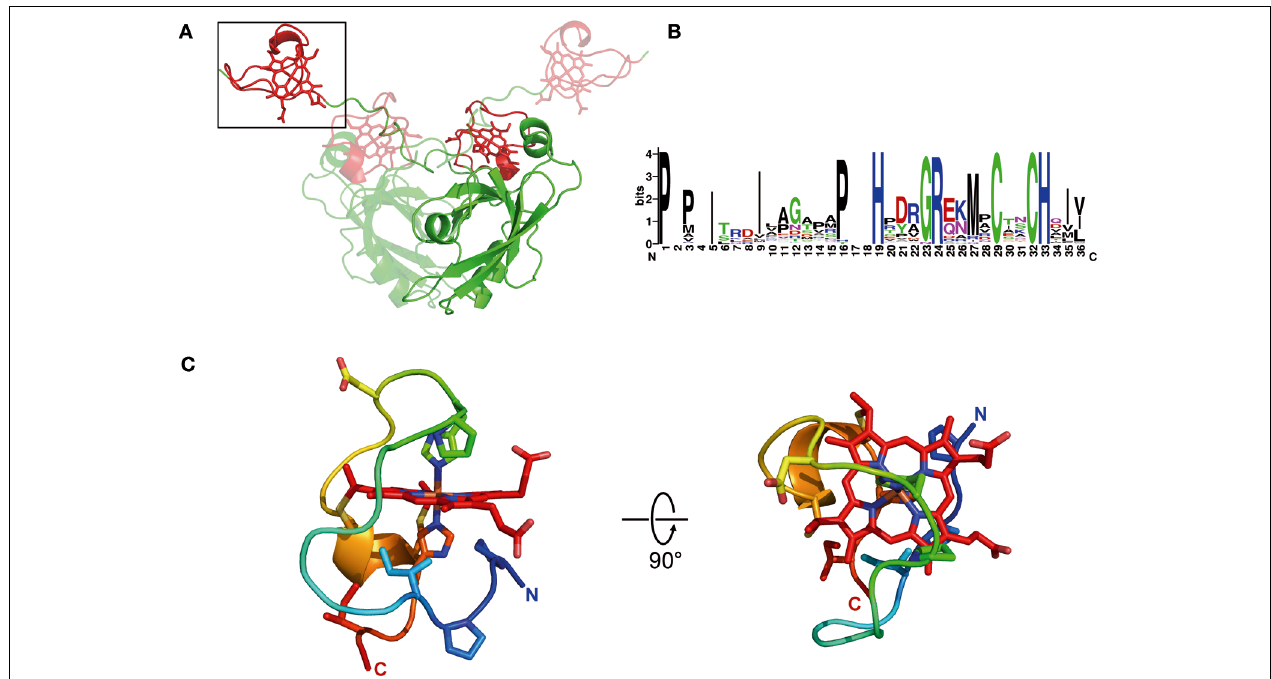
FIGURE 1 | Structure of MCR. (A) Overall structure of the MamP dimer with both monomers colored according to their domain organization (PDZ in green and magnetochrome domains in red), with one monomer rendered in transparency. (B) Weblogo (http://weblogo.berkeley.edu/)